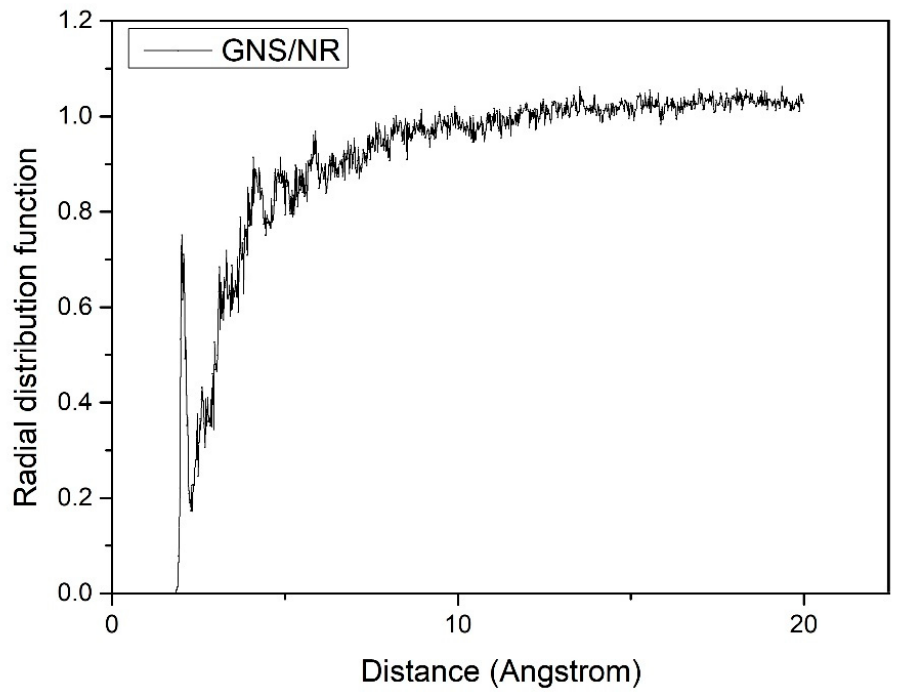
Figure 4. Radial distribution function between graphene and the natural rubber matrix during the tensile process.